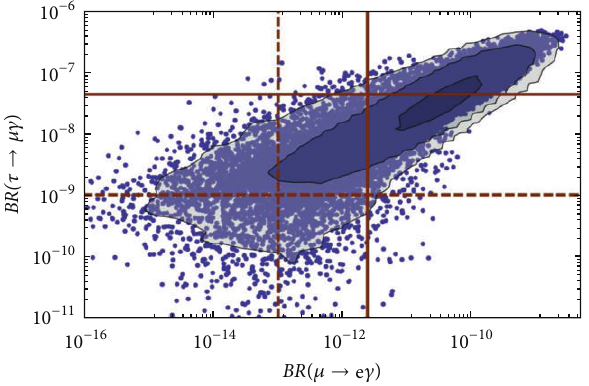
Figure 8: Correlation between the expected 𝜏 → 𝜇𝛾 and 𝜇 → e 𝛾 𝐵𝑅 s in SUSY see-saw models where only one of squark families has a mass in the TeV range [77], while the others are allowed to have higher